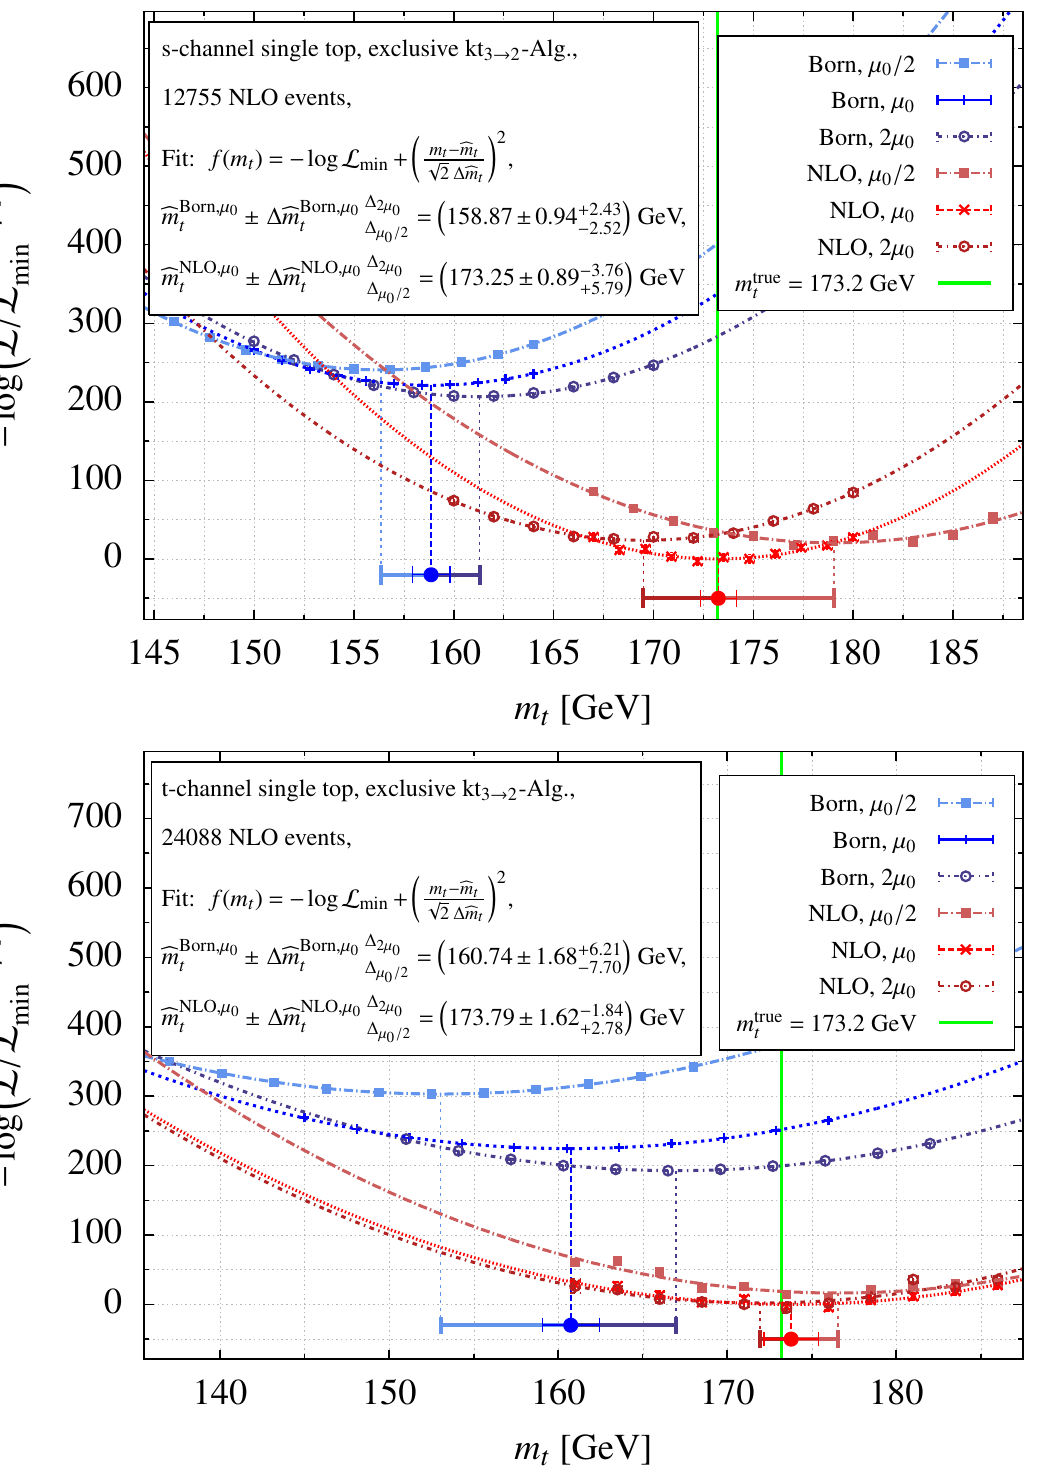
Figure 13 . Extraction of the top-quark mass from exclusive s -channel (top) and t -channel (bottom) single top-quark events employing NLO (reddish) and Born likelihoods (blueish) using a parabola (cid:12)t around the